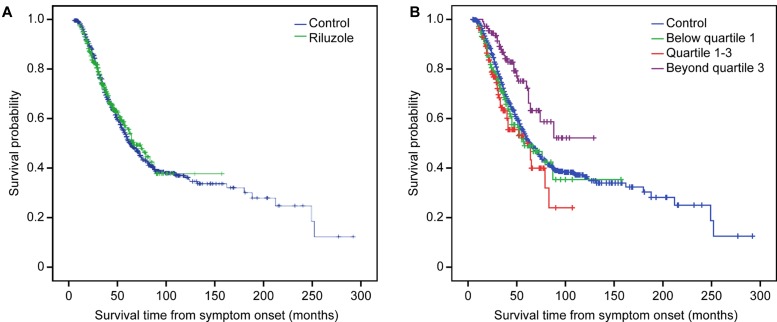
Kaplan-Meier survival curves.
(A) Survival analysis stratified by riluzole; (B) Survival analysis stratified by quartiles of dose of riluzole.